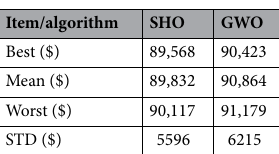
Table 9. Statistic analysis of different algorithms performance with